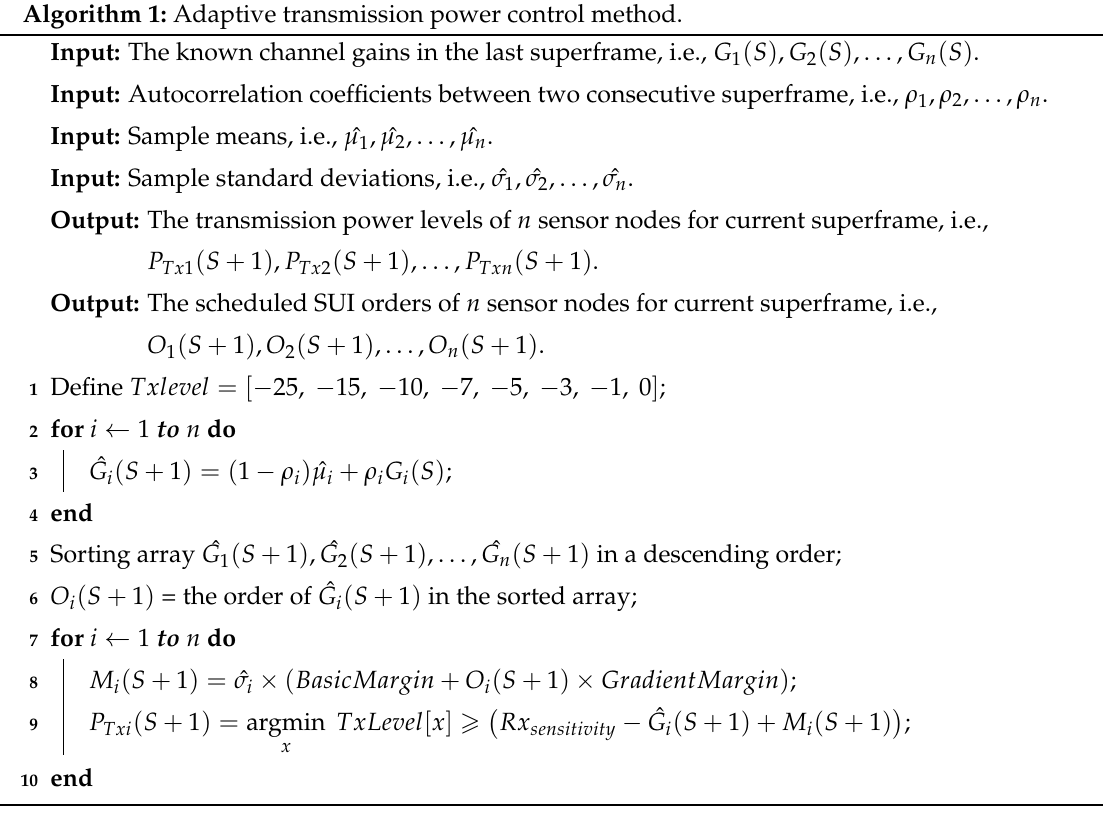
Algorithm 1 requires the following four inputs: the last known channel gain, autocorrelation coefficients between two consecutive superframes, the sample means, and the sample standard deviations. These inputs are used to schedule the SUI order and adapt the transmission